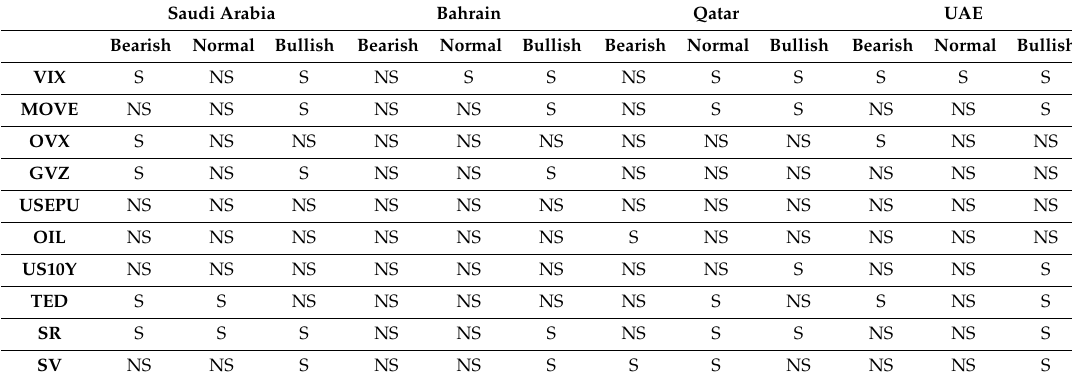
Table 7. Summary of the empirical